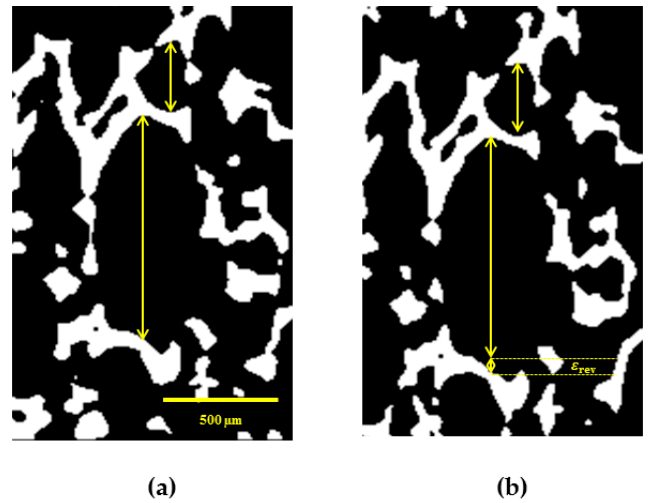
Figure 13. µ CT image of cPCL-2/4/8k-180 in the direction of programming: ( a ) at T high = 49 ± 1 ◦ C; and ( b ) at T low = 22 ± 1 ◦ C. Yellow arrows have length of corresponding pores at T high . The gap between the arrows and the corresponding pore walls at T low indicates an rSME of a pore ( ε rev ). Scale is 500 µm.